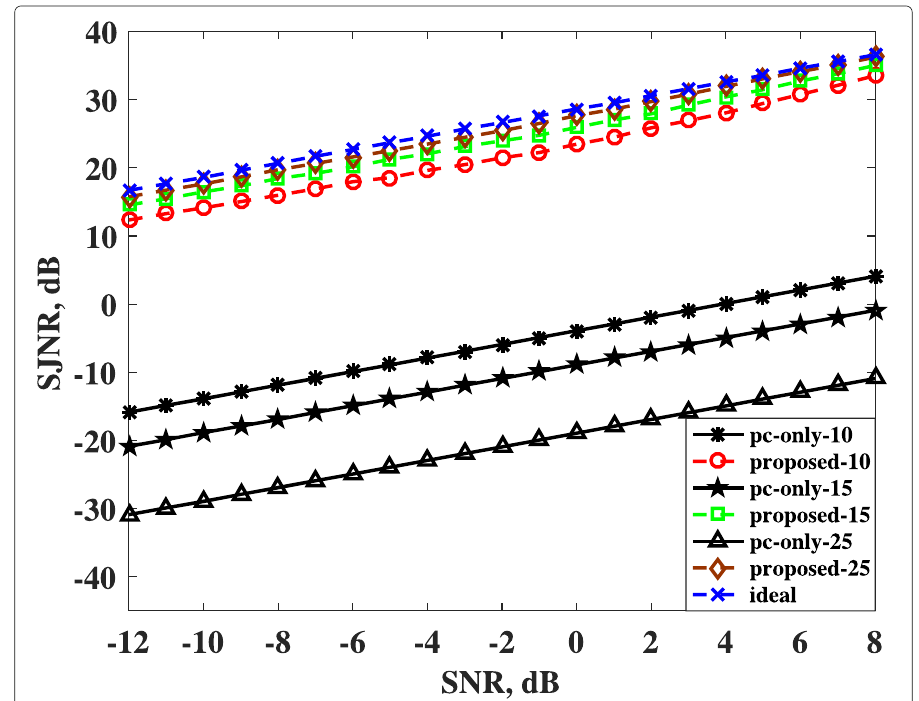
Fig. 8 The output SJNR under different input SNR in the DFTJ